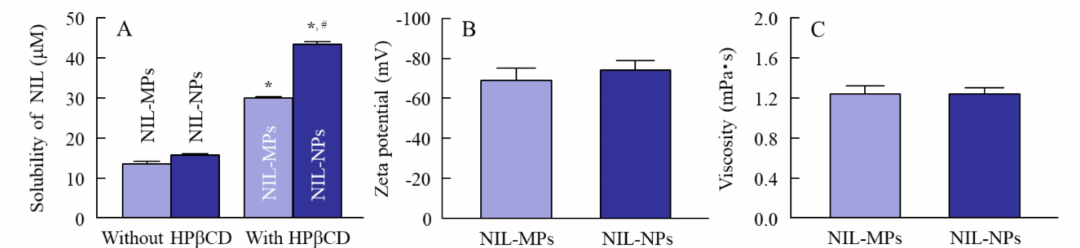
Figure 3. Changes in the drug solubility, zeta potential, and viscosity of the NIL dispersions treated with or without a bead mill. ( A) Solubility in the milled NIL dispersions with or without HP β CD. ( B ) Zeta potential of the NIL in the NIL-MP and NIL-NP dispersions. ( C ) Viscosity of NIL-MP and NIL-NP dispersions. n = 5–8. * p < 0.05, vs. NIL dispersions without HP β CD for each category. # p < 0.05, vs. NIL-MP dispersions for each category. The solubility of NIL was increased by the bead mill treatment, and the constants of the HP β CD-NIL inclusion complexes in the NIL-NPs were also higher than those in the NIL-MPs. The zeta potential and viscosity of the NIL-MP and NIL-NP dispersions were not different.